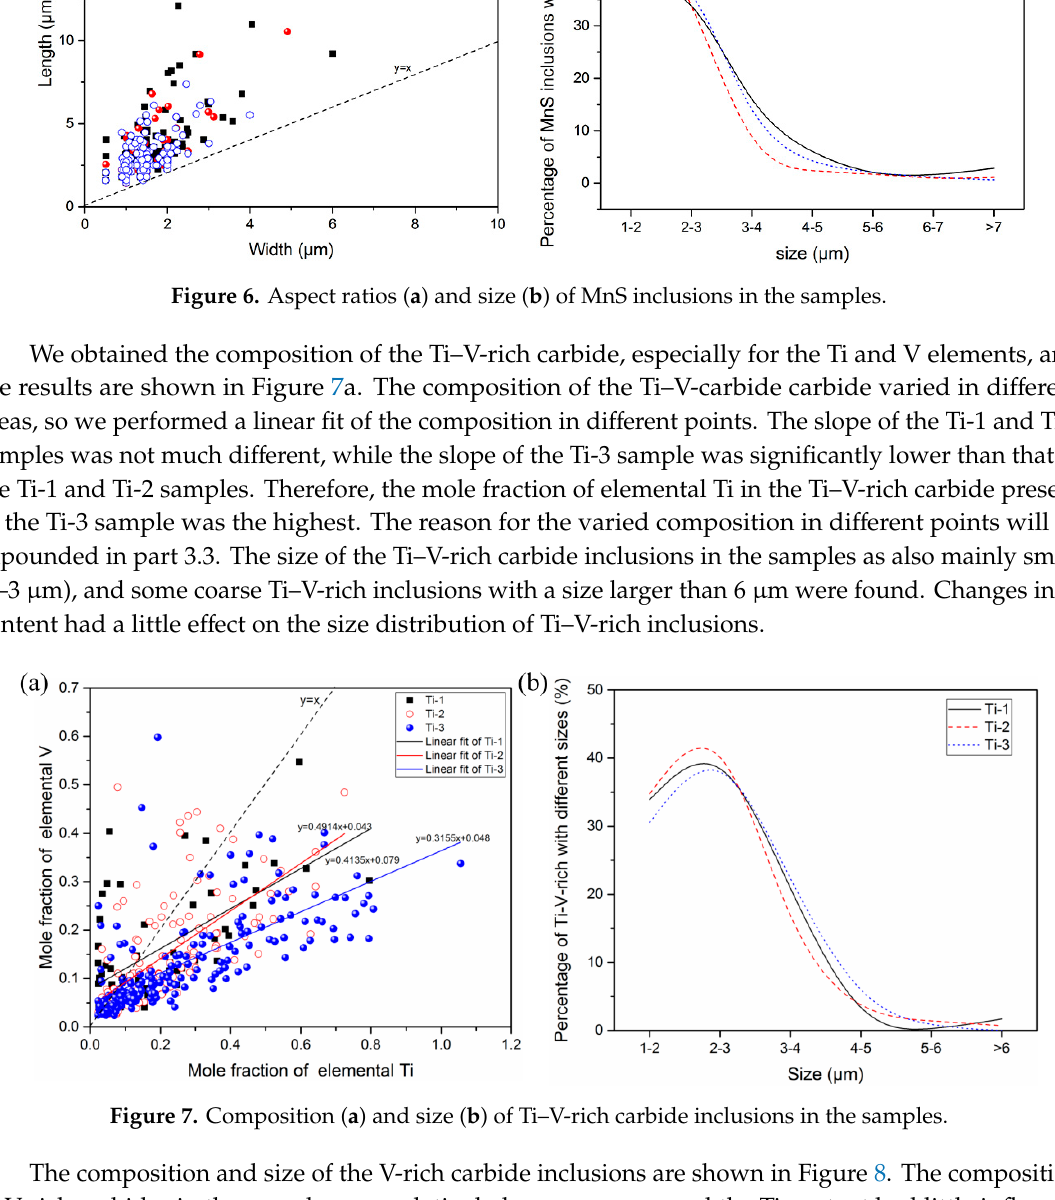
Figure 8. Composition ( a–c ) and size ( d ) of V-rich carbide inclusions in the samples. 3.3. Three-Dimensional Characteristics of the Primary Carbides in the Samples A schematic diagram of the differences between the 2D and the 3D observations is shown in Figure 9. There was a great difference between the 2D and the 3D morphologies of the primary carbides. The shape of the primary carbides according to the 3D observations was similar to a tree, including trunk and branches. There were multiple branches on the trunk, and the area of the branches was much larger than that of the trunk. The elemental mapping of the primary carbides as observed by 3D analysis is shown in Figure 10. Elemental Ti and V were obviously enriched in the